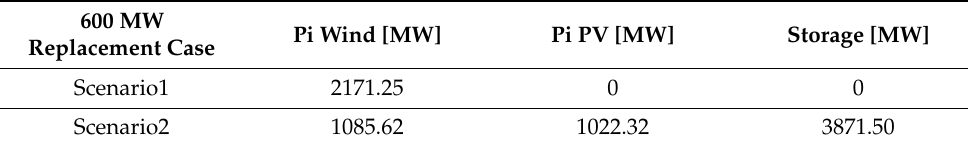
Table 6. The 600 MW replacement